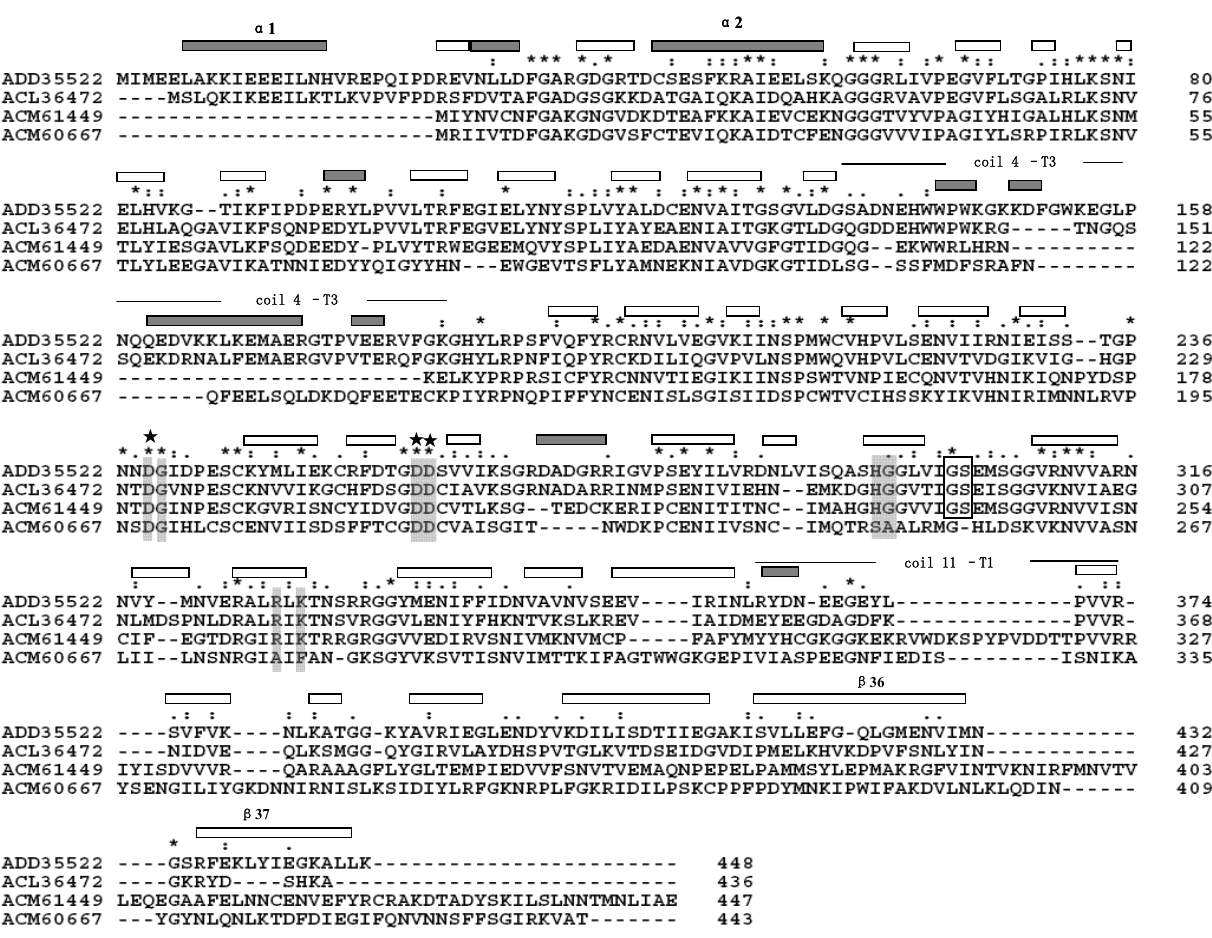
Figure 2. Multiple sequence alignment of bacterial EPGs. The alignment was performed in Clustal X 1.83 with default parameters. Active sites are marked with asterisks. Substrate-binding sites are indicated by a grey background. The secondary structure elements of AAD35522 (PelB) are indicated above the alignment (open square, α -helix; solid square, β -sheet). G230–S231 cis -peptide (ACM61499 reference) is indicated by an open square. The strongly conserved positions are marked above the alignment with “ * ”, “ : ” and “ . ”; The residue number of four sequences is indicated on the right,